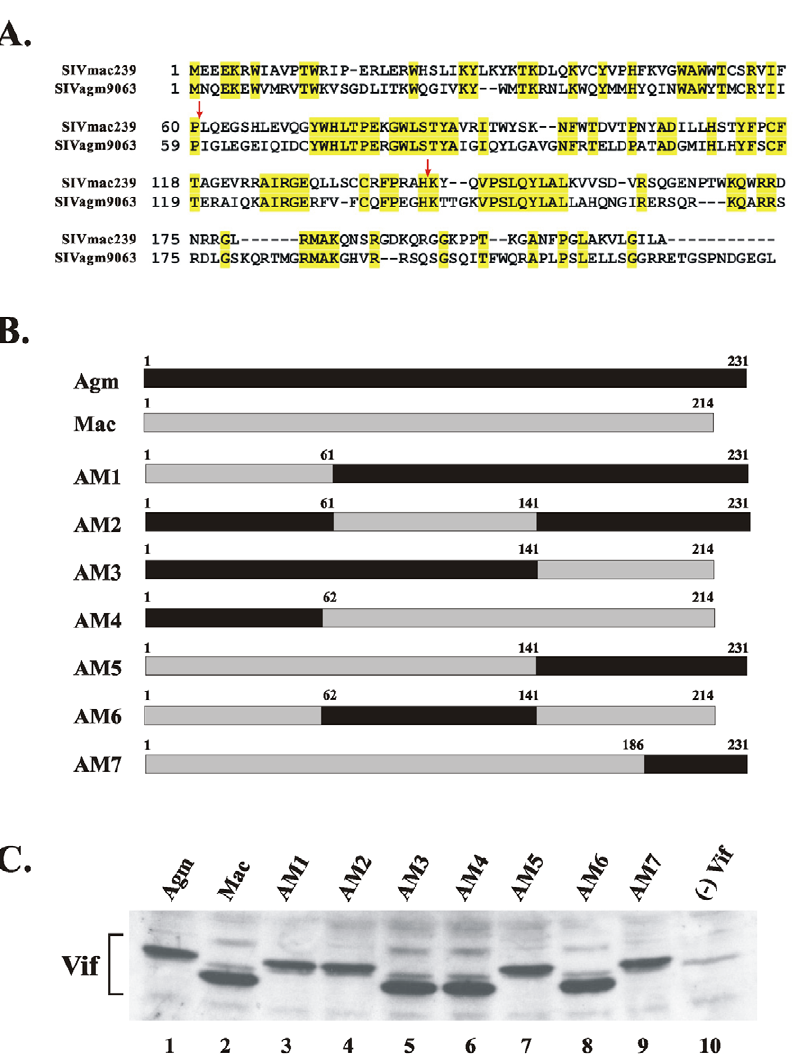
Figure 2. Construction and expression of SIVmac/agm Vif chimeras. ( A ) Alignment of SIV Mac239 and SIV Agm9063 Vif. The fusion points between chimeras are indicated as red arrows. ( B ) SIVmac/agm chimeras were constructed by PCR based mutagenesis as described in the Methods section. These mutants are labeled as AM1–AM7. The numbers above each construct indicate the amino acid positions for each fusion point. ( C ) HeLa cells were transfected with 5 m g of plasmid DNA encoding wild type SIVagm9063 Vif (lane 1), wild type SIVmac239 Vif (lane 2) or the various chimeras (AM1–AM7, lanes 3–9). A Vif-negative sample was included as a control (lane 10). Whole-cell lysates were prepared 48 hr after transfection and aliquots from each sample were analyzed by immunoblotting using an antibody cocktail against SIVmac239 and SIVagm9063 Vif